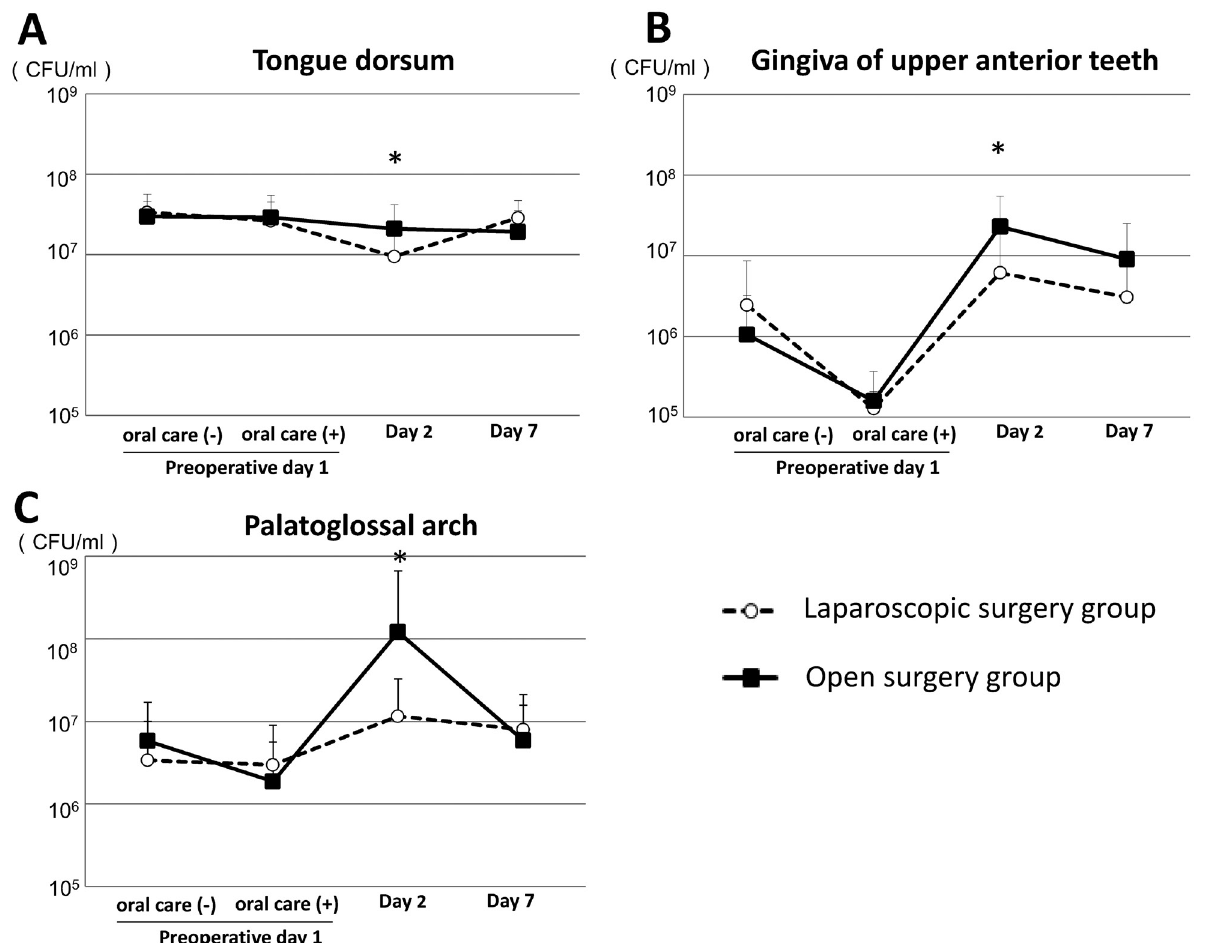
Figure 2- Comparison of oral bacterial counts between laparoscopic surgery and open surgery groups. (A) Numbers of oral bacteria on the dorsum of the tongue. Error bars represent mean±SD. There were statistically significant differences between the groups. *p<0.05; (B) Numbers of oral bacteria on the gingiva of upper anterior teeth; (C) Numbers of oral bacteria on the palatoglossal